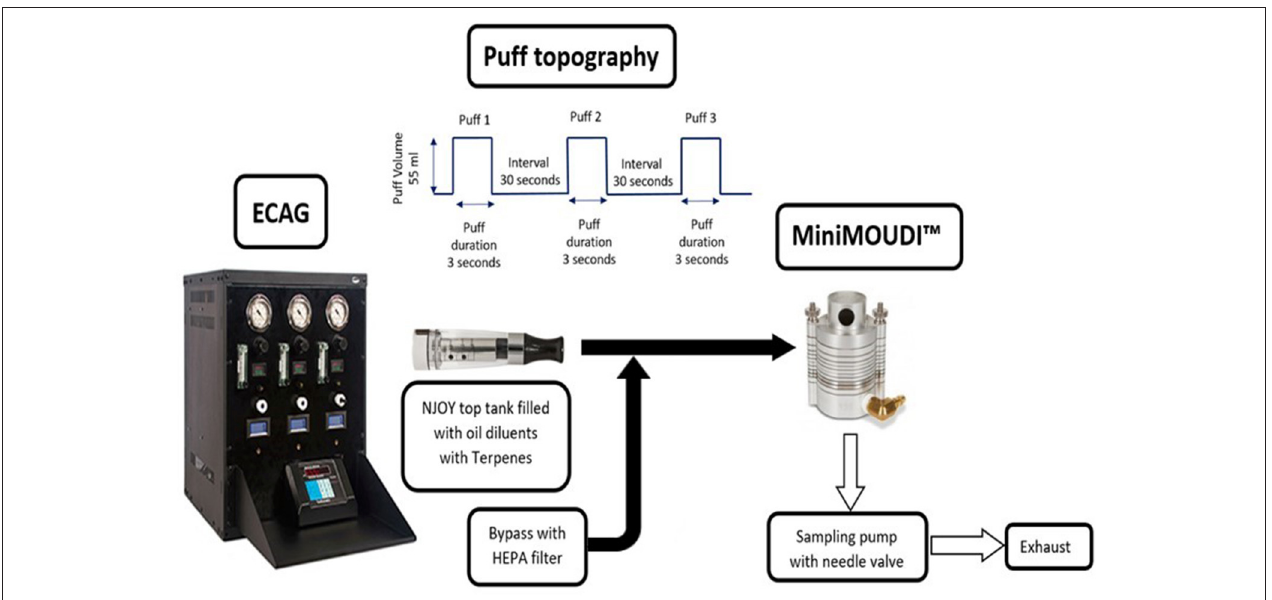
FIGURE 1 | Schematics of the experimental